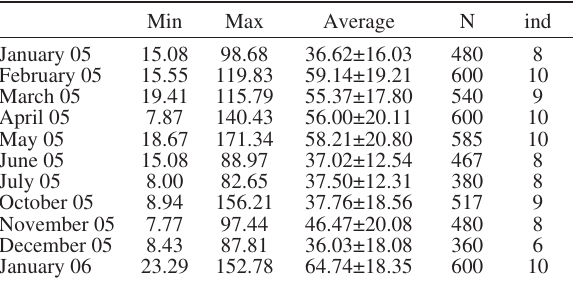
Table 3. – Monthly minimum (Min), maximum (Max), and aver- age (±SD) oocyte sizes per month throughout the study period. N is the number of oocytes counted out of the number of individuals indicated in the ind column. Min